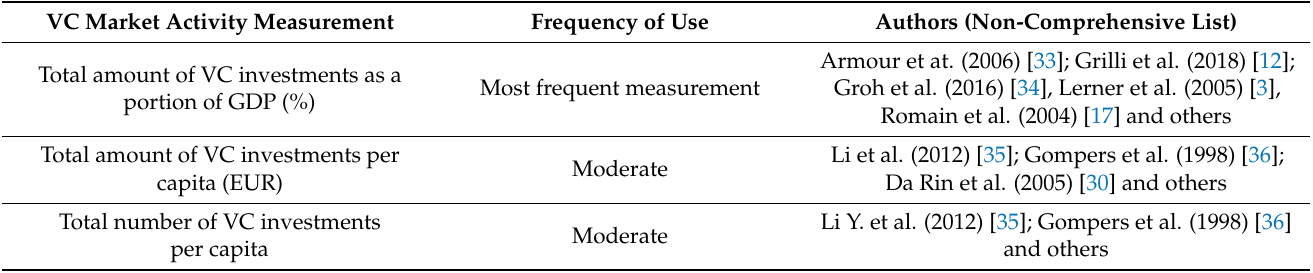
Table 2. VC market activity